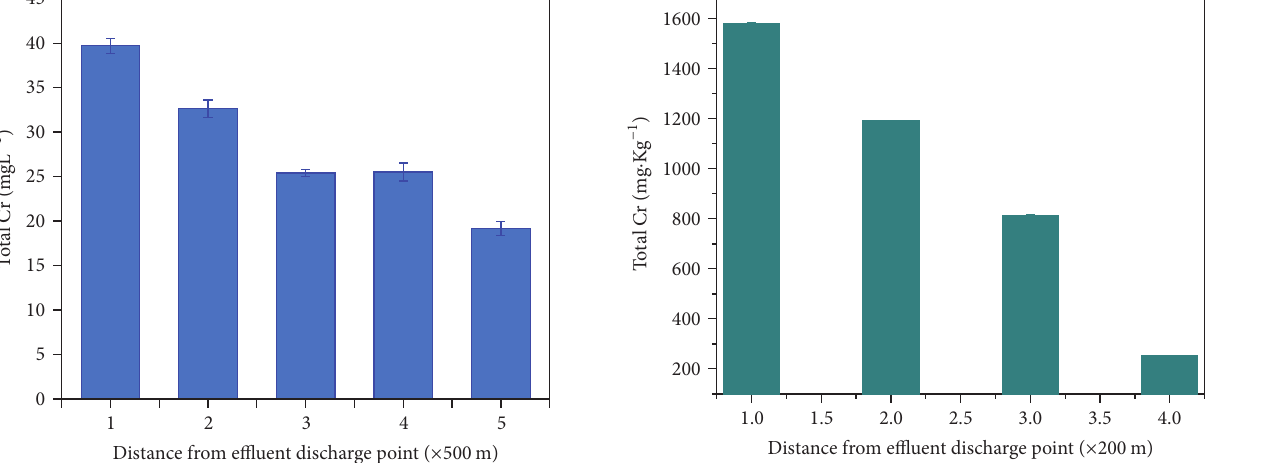
Figure 2: Mean values and standard deviations of total Cr con- centrations recorded in wastewater samples collected at different distances from the tannery effluent discharge point.